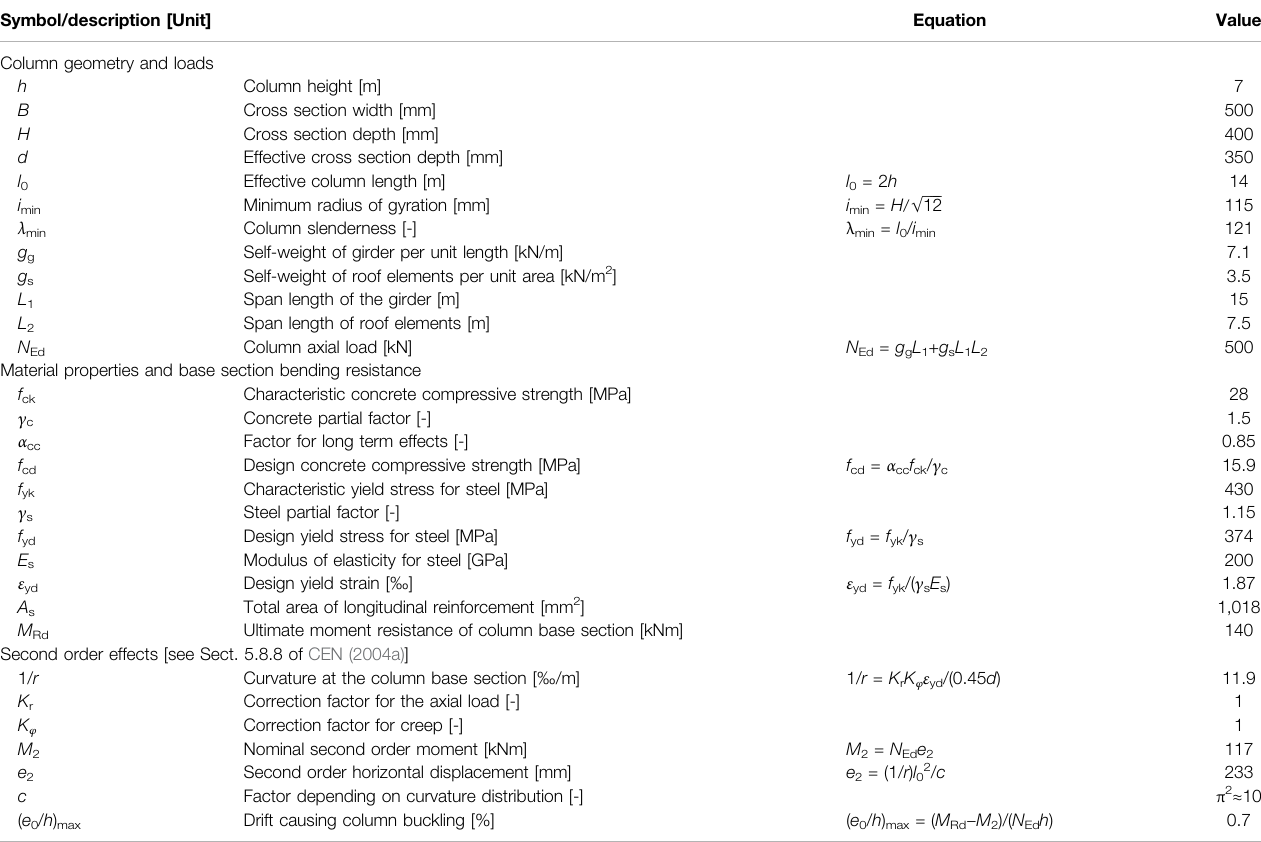
TABLE1| EstimateoftheresidualdriftcorrespondingtoinstabilityunderpermanentloadsforatypicalprecastRCcolumn( Figure1 )notdesignedforearthquakeresistance. Symbol/description